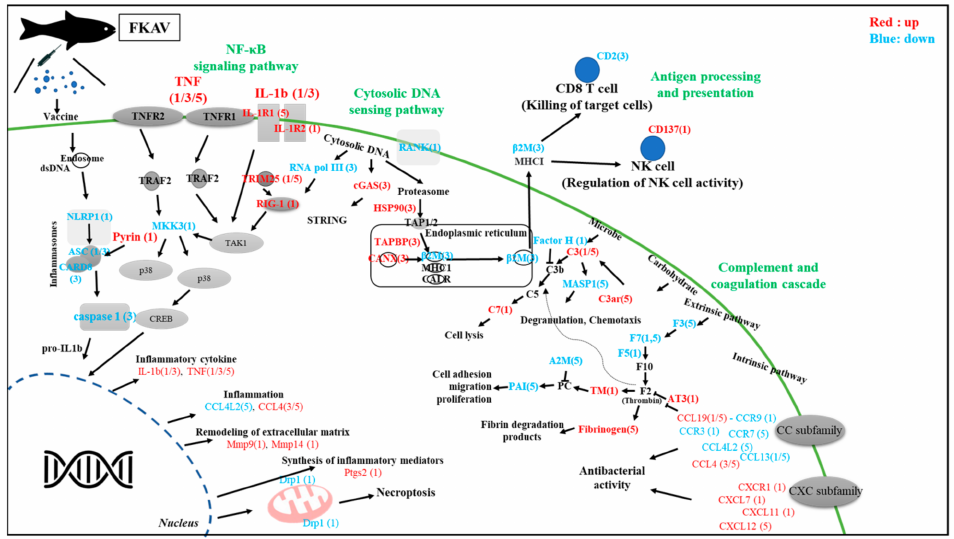
Figure 5. Presentation of putative immune pathways at days 1, 3, and 5 in AV group. DEGs regulated by AV vaccine are shown in red (upregulated) or blue (downregulated). The number next to the gene indicates the time point of reaction. Black arrows show activation and regulatory responses of downstream